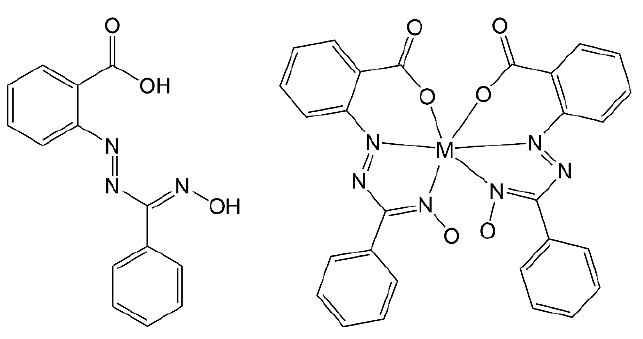
Table 1. Crystallographic parameters of complexes